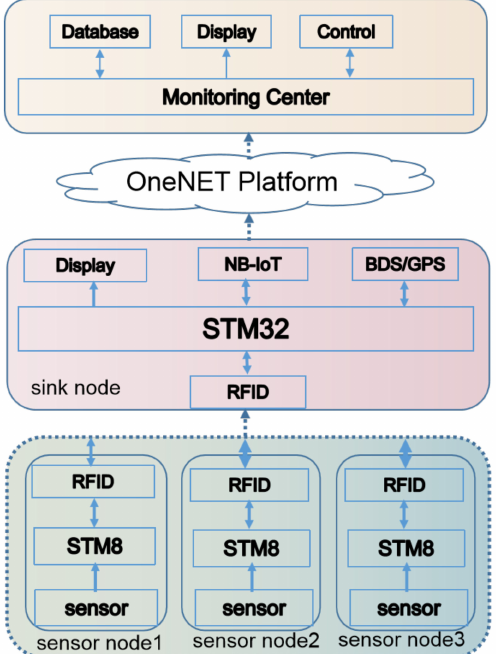
Figure 1. Hardware frame of the monitoring